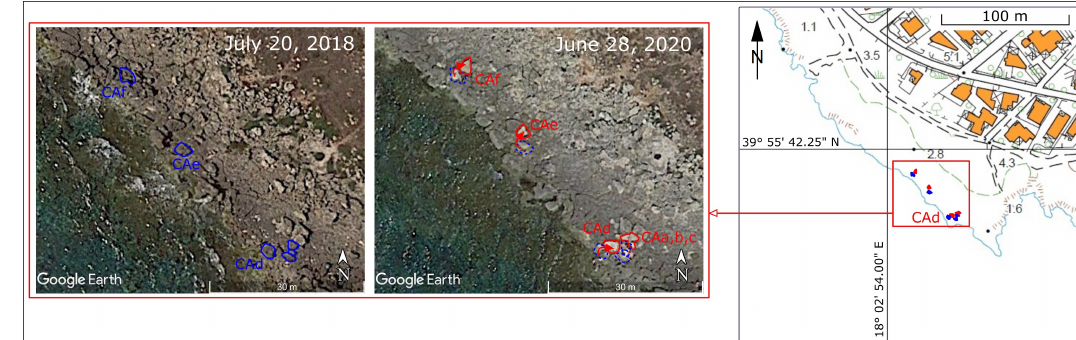
Figure 9. Comparative satellite images of Capilungo. The initial positions of the boulders are highlighted in blue, and the final ones in red. Red arrows highlight the displacements. Topography from the technical map of Lecce Province